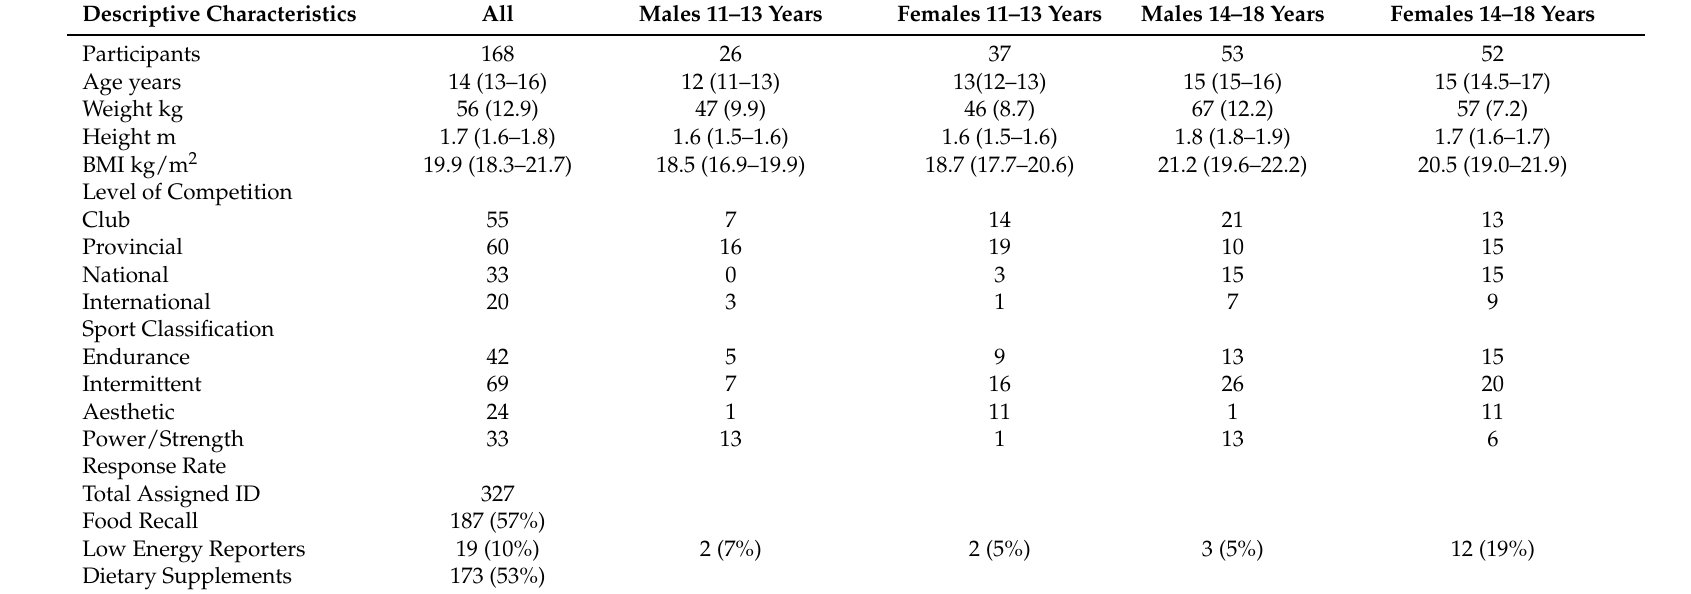
Table 1. Descriptive